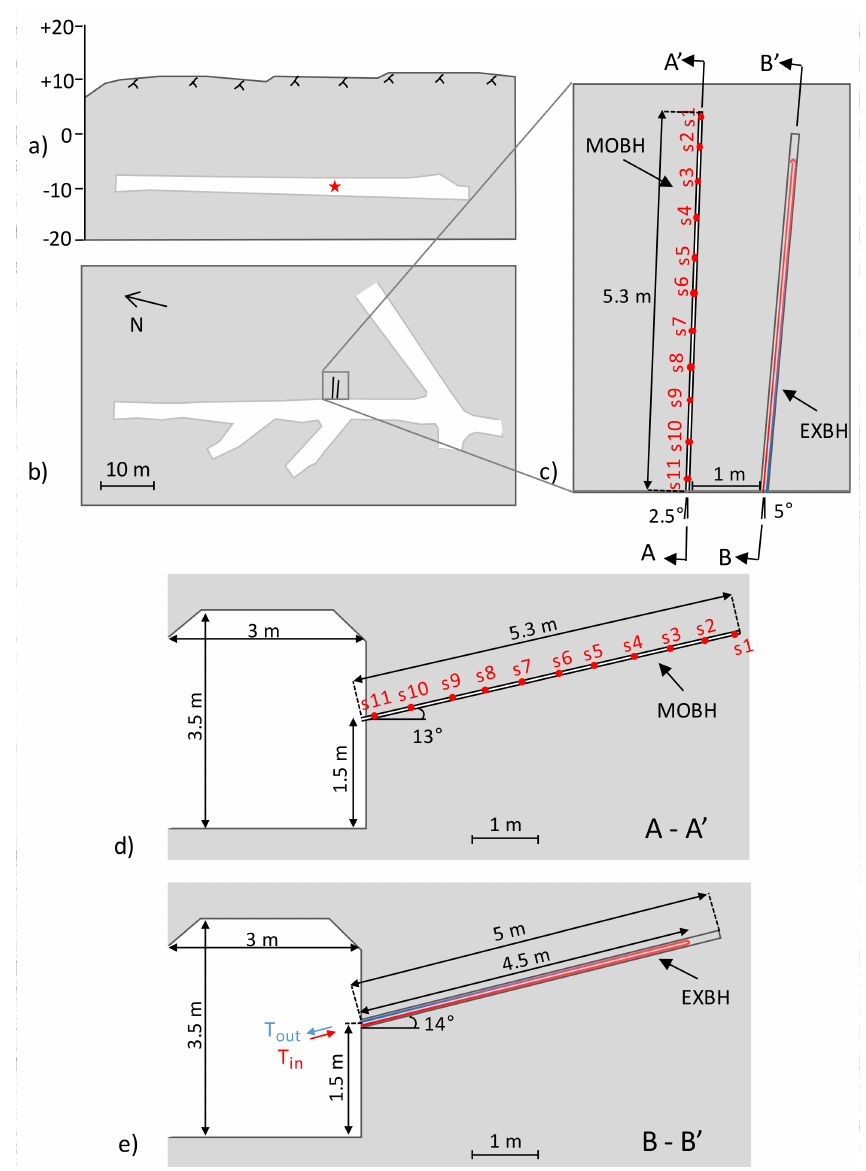
Figure 2. The sketch of the experiment area: ( a ) vertical section of the research tunnel; ( b ) horizontal section of the research tunnel; ( c ) enlarged horizontal section of the experiment area; ( d ) vertical section along the monitoring borehole (MOBH); and ( e ) vertical section along the experimental borehole